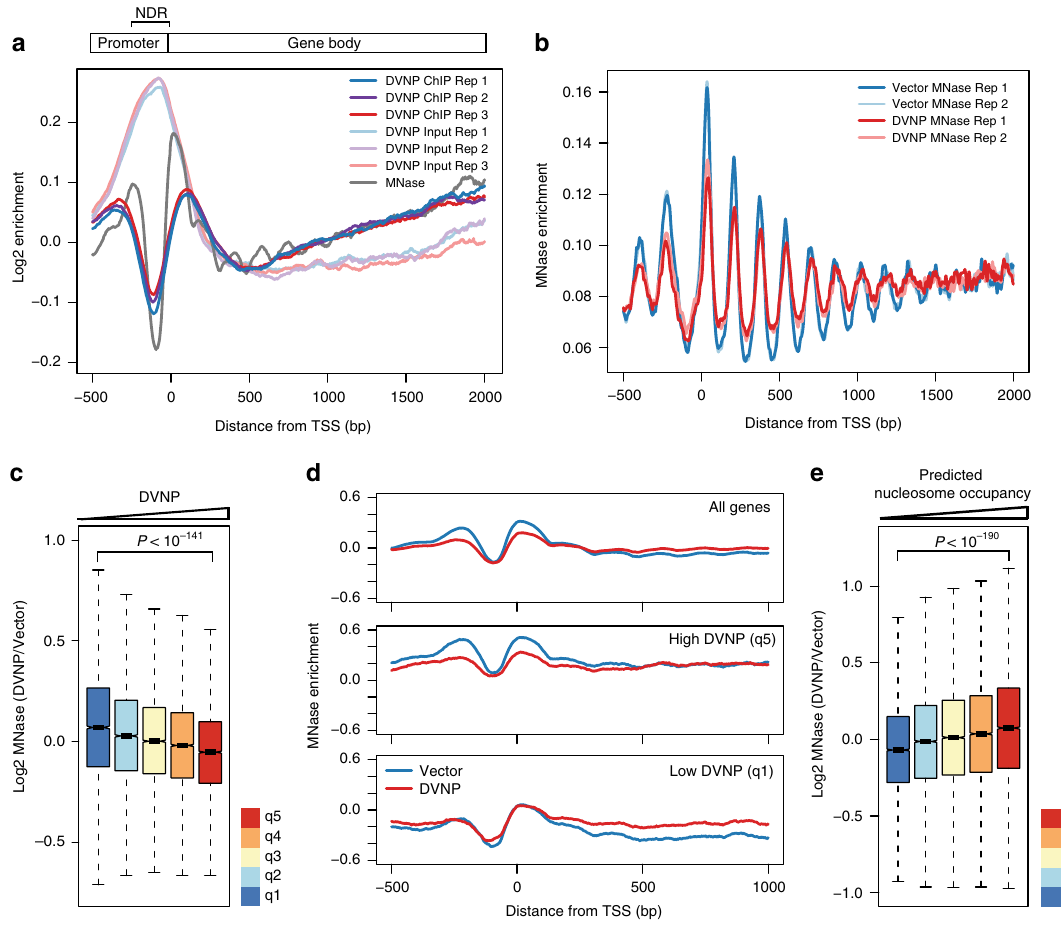
–0.50.00.51.0 s e N a M Fig. 2 DVNP binds nucleosomal regions and induces histone loss in S. cerevisiae . a Average gene plot showing the relative enrichment of DVNP chromatin immunoprecipitates (ChIPs), and ChIP inputs from DVNP-3HA-NLS-expressing cells. Three biological replicates are shown for the ChIP and input. Also shown is the enrichment pro fi le for MNase-digested control cells. A schematic of an average gene is shown above, with the nucleosome- depleted region (NDR) labeled. DVNP ChIP and input replicates were combined in all subsequent analyses. b Average gene plot showing MNase digested DNA from two biological replicates obtained from DVNP-3HA-NLS-expressing and control cells. Enrichment was calculated from read midpoints and Gaussian smoothed with a standard deviation of 4. MNase-seq replicates were combined in all further analyses. c Genome-wide relationship between DVNP and nucleosome loss. Five hundred base pair genomic windows were binned into 20% DVNP quintiles (q1-5, see Supplementary Fig. 2b) and nucleosome loss is shown in these bins ( n = 9659). Outliers are shown in Supplementary Fig. 2g. d Average gene plots showing MNase pro fi les for DVNP- 3HA-NLS-expressing and control cells. Averages were calculated from all genes (top panel), or genes with the top (q5, middle panel) or bottom (q1, bottom panel) 20% DVNP enrichment over the gene body (see Supplementary Fig. 2d). e Genome-wide association between predicted nucleosome occupancy and nucleosome loss due to DVNP expression. Nucleosome bound sites were binned into 20% predicted occupancy quintiles (q1-5, see Supplementary Fig. 2f) and nucleosome loss is shown in these bins ( n = 13,509). Outliers are shown in Supplementary Fig. 2h. All P -values were calculated using two sided Welch ’ s t -tests. Box plot notches represent an estimate of the 95% con fi dence interval of the